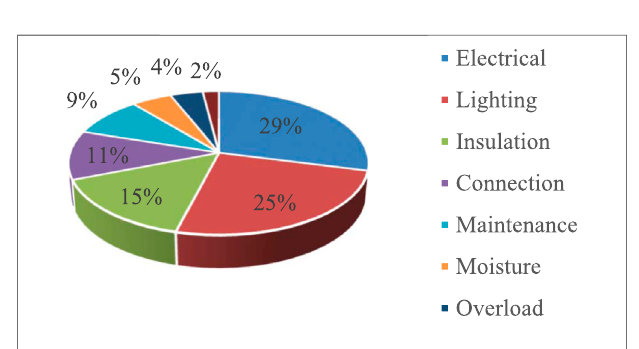
FIGURE 3 | Transformer failure